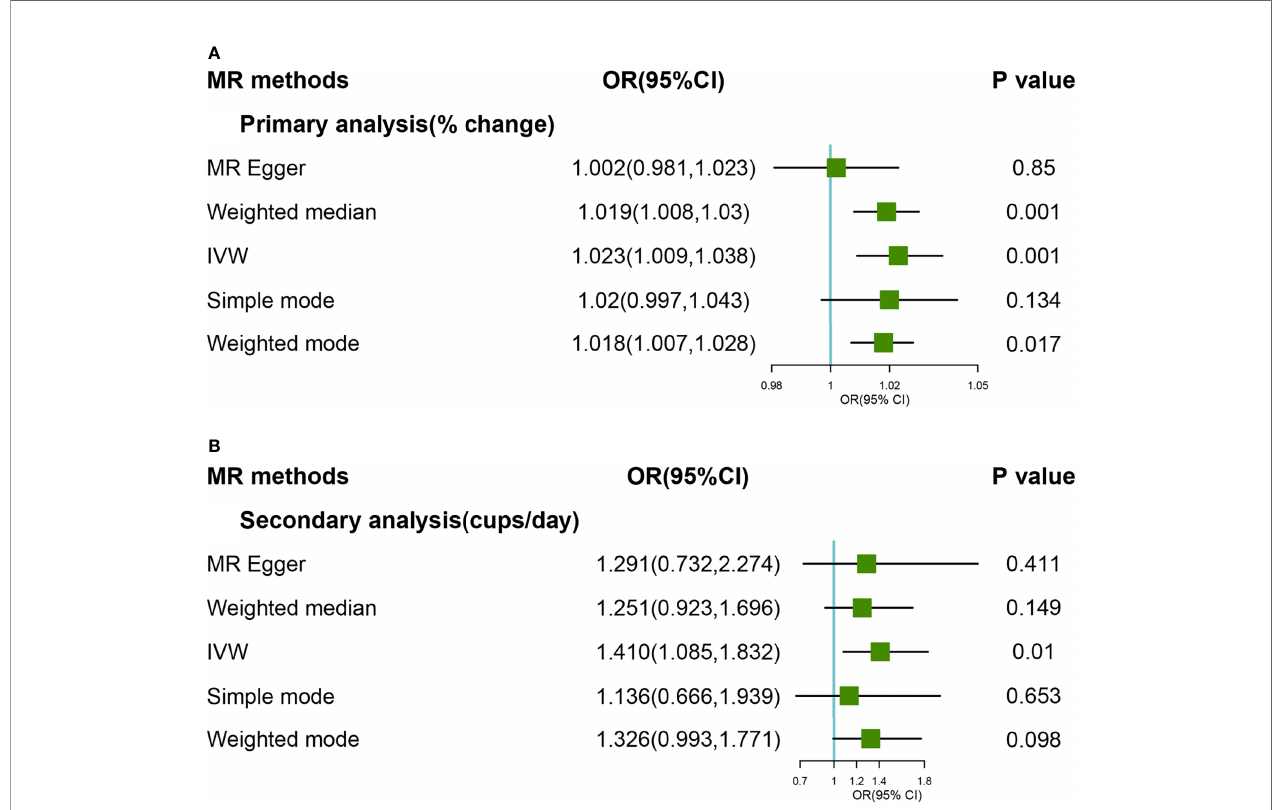
FIGURE 2 | Forest plot of MR study using (A) primary genetic instruments with knee OA after excluding four SNPs (rs4410790, rs597045, rs34060476, and rs1956218). MR, Mendelian randomization; OR, odds ratio; CI, con fi dence interval; IVW, inverse variance weighted; OA, Osteoarthritis. Forest plot of MR study using (B) secondary genetic instruments with knee OA. MR, Mendelian randomization; OR, odds ratio; CI, con fi dence interval; IVW, inverse variance weighted; OA,